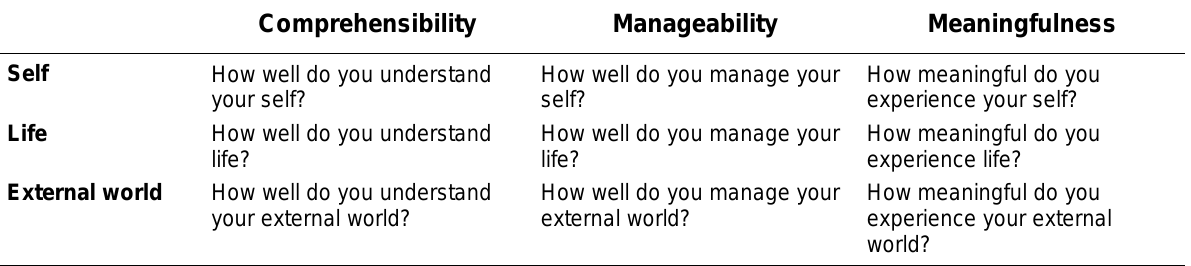
United Basic Questions Based on Table